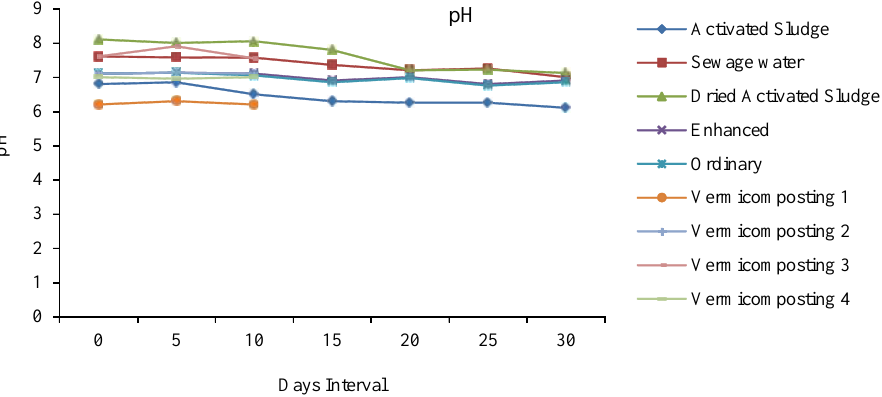
Fig. 4: Comparison of pH between the initial and final